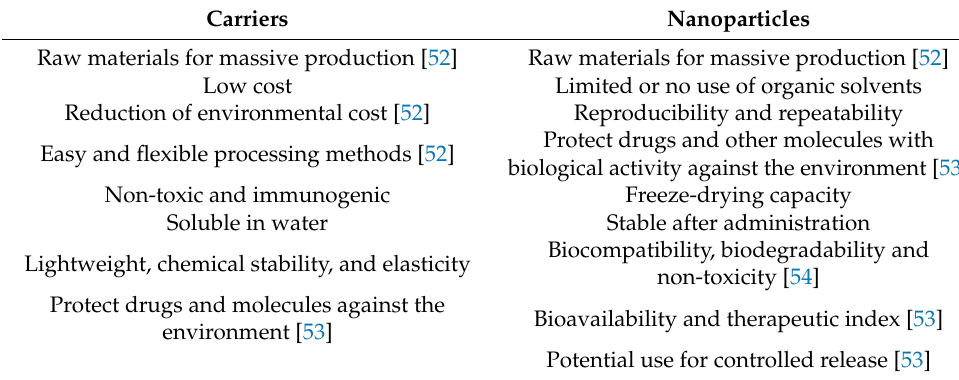
Table 5. Criteria for ideal polymeric carriers for nanoparticle delivery systems [50].